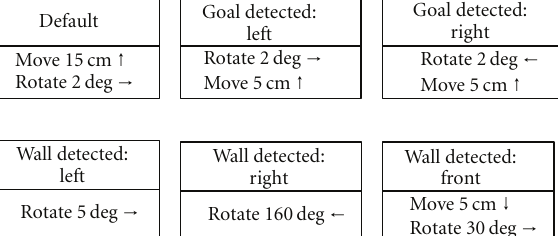
the same except the robot deployed in the game. Either a real robot or a virtual robot was deployed for each setup. In